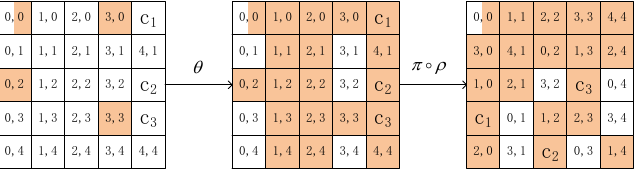
Figure 8: Diffusion of the 56-bit Keys in A [0 , 2], A [3 , 0], A [3 , 3], Half of A [0 , 0] and 32-dimension Cube